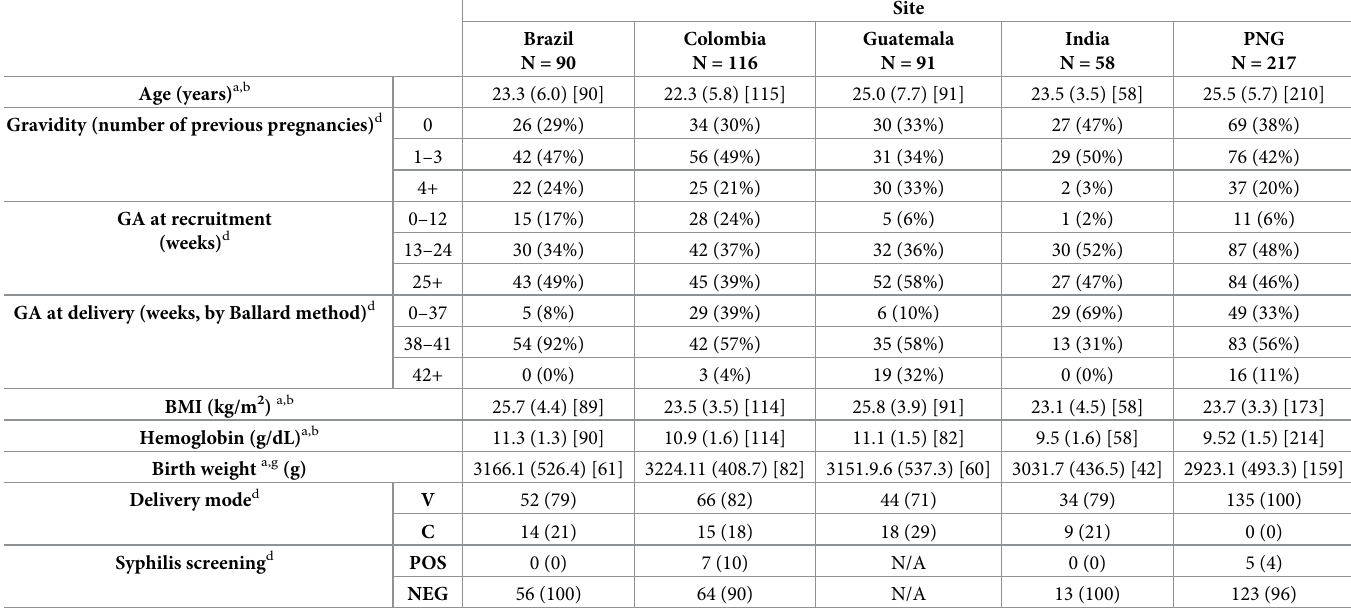
Table 1. Baseline characteristics of study population. This refers to all the women included in the study at both